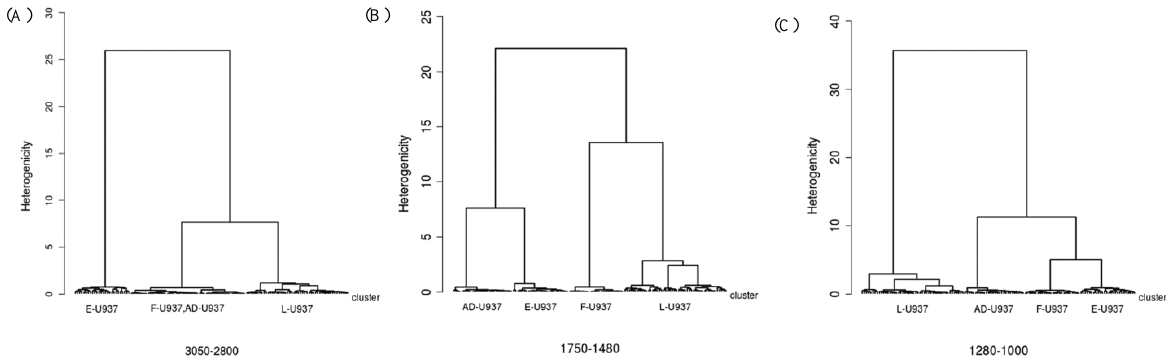
HCA (Euclidean distances, Wards’ algorithm) in the regions of ( A ) lipids; ( B ) proteins-phospholipids; and ( C ) nucleic acids-carbohydrates; ( D – F ) centroids of the major classes identified by HCA in the ( D ) lipids; ( E ) proteins-phospholipids; and ( F ) nucleic acids-carbohydrates regions. Line thickness is proportional to standard deviation, (Reprinted with permission from [6]. Copyright 2012 American Chemical